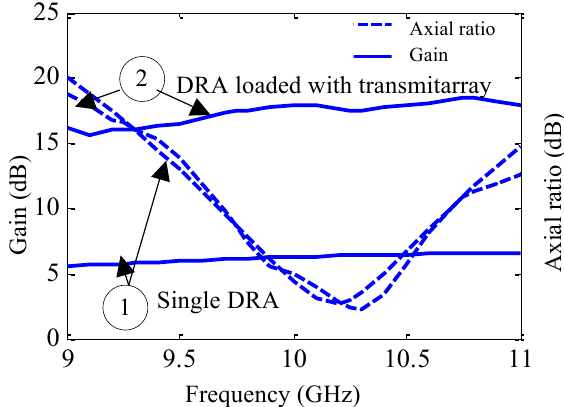
Figure 21: The gain and the axial ratio versus frequency for DRA loaded with transmitarray compared to a single DRA. Table 1: The radiation characteristics of 9x9 etching transmitarray fed by single elliptic DRA element for different ratios F/D.